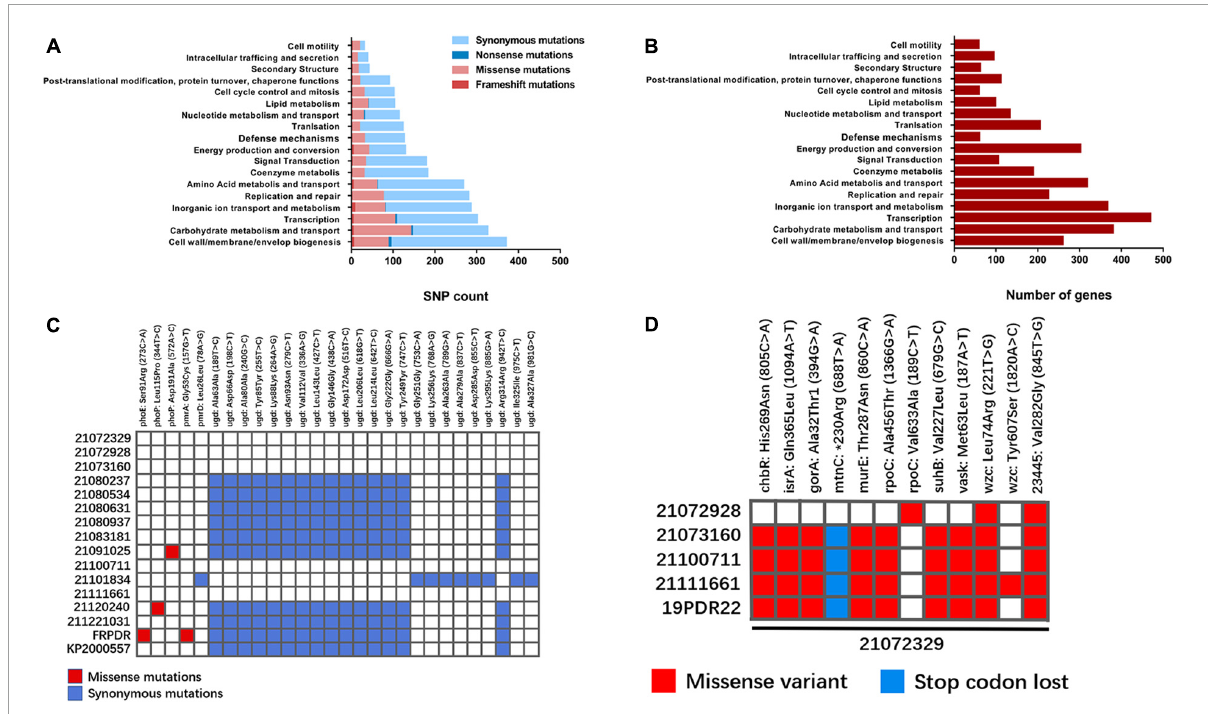
FIGURE6 Mutational analysis of ST11 K. pneumoniae isolates. (A) Using 2107239 as the reference genome, enrichment analysis of COG categories for genes mutated in ST11 K. pneumoniae isolates. Different types of mutations are represented by different colors (Huerta-Cepas et al., 2019). (B) Distribution of functional genes annotated in 21072329 by eggNOG 5.0. (C) Mutations in polymyxin-related genes in ST11 K. pneumoniae isolates. Missense mutations are shown in red and nonsense mutations are shown in blue. (D) Differences in SNPs shared by 21072329 with other ST11-KL47 K. pneumoniae